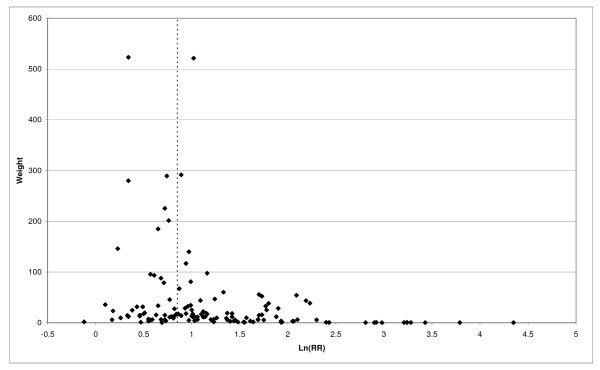
Funnel plot for ever smoking and COPD. Funnel plot of the 129 relative risk estimates for ever smoking and COPD included in the main meta-analysis in Table 5 against their weight (inverse-variance of log RR). The dotted vertical line indicates the fixed-effect meta-analysis estimate.